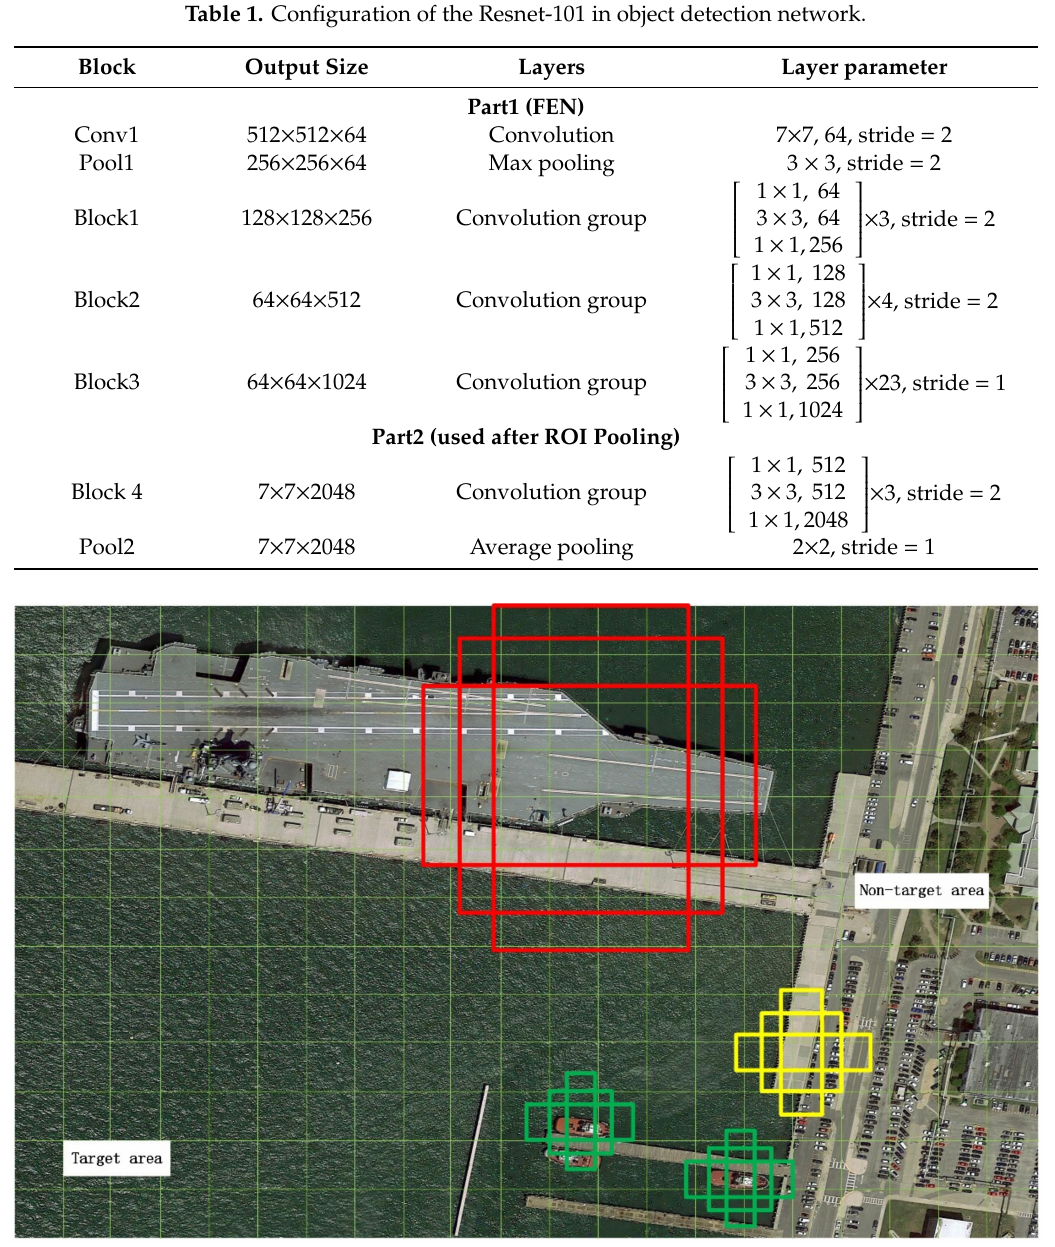
Figure 5. Mechanism of Region Proposal Network (RPN) [14] by using the multi fixed scales anchors to conduct the region proposal in the original image, where the red boxes represent the large-scale targets which cannot be fully covered, the yellow boxes represent the false alarm on the land, and the green boxes focus on the correct targets with a small